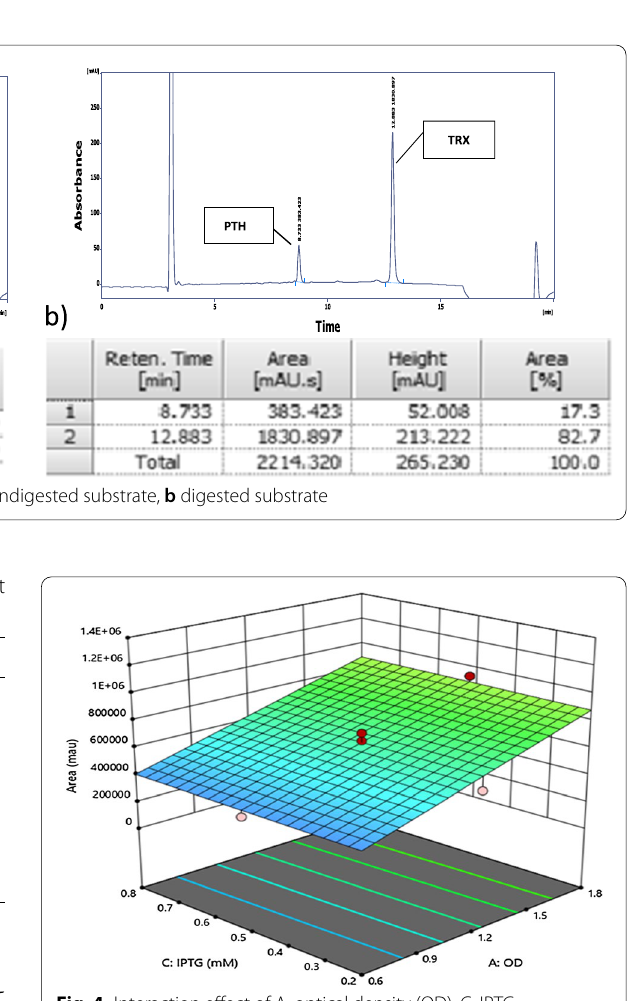
Fig. 4 Interaction effect of A: optical density (OD), C: IPTG concentration, Shuffle T7 strain has been selected as actual factor in 3D surface